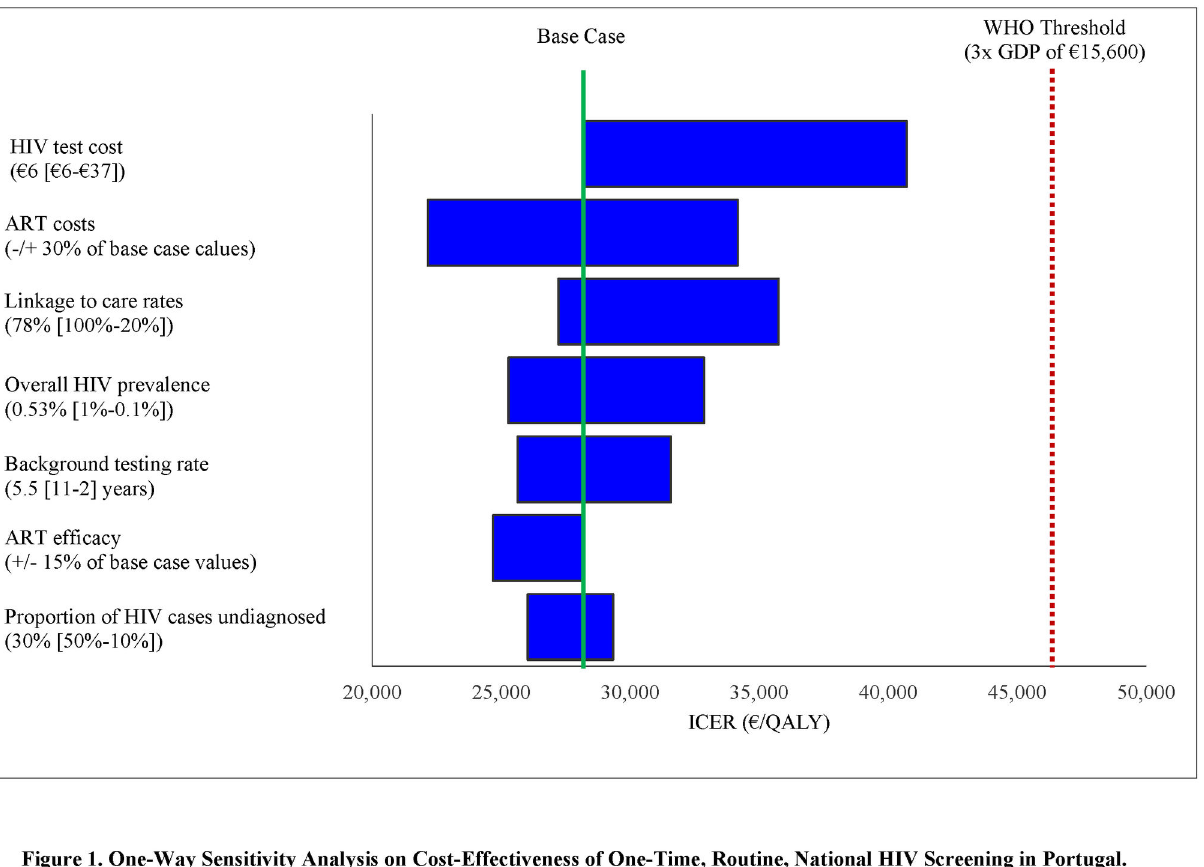
Figure 1. One-Way Sensitivity Analysis on Cost-Effectiveness of One-Time, Routine, National HIV Screening in Portugal. The width of the bar is the variation in the incremental cost-effectiveness ratio associated with alternative parameter values for that input, when secondary transmissions are taken into account. The numbers in parentheses next to each parameter on the y-axis indicate the base case value, and the numbers in brackets indicate the lower and upper-bounds used in the sensitivity analyses. QALY: quality-adjusted life year. ICER: incremental cost-effectiveness ratio. doi: